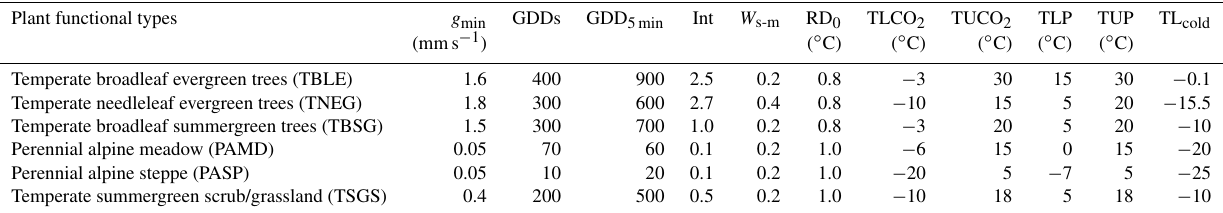
Table 1. Calibrated parameters of plant functional types in the Lund–Potsdam–Jena DGVM model. Plant functional types Temperate broadleaf evergreen trees (TBLE)